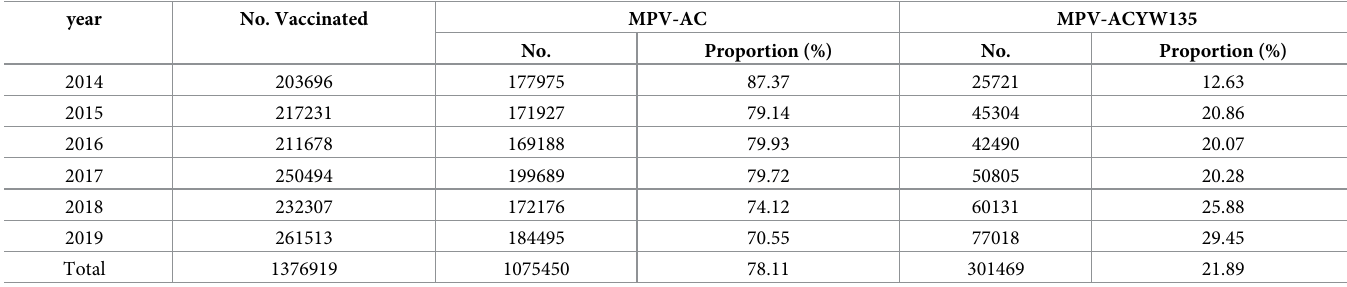
Table 2. The proportion of children using MPV-AC or